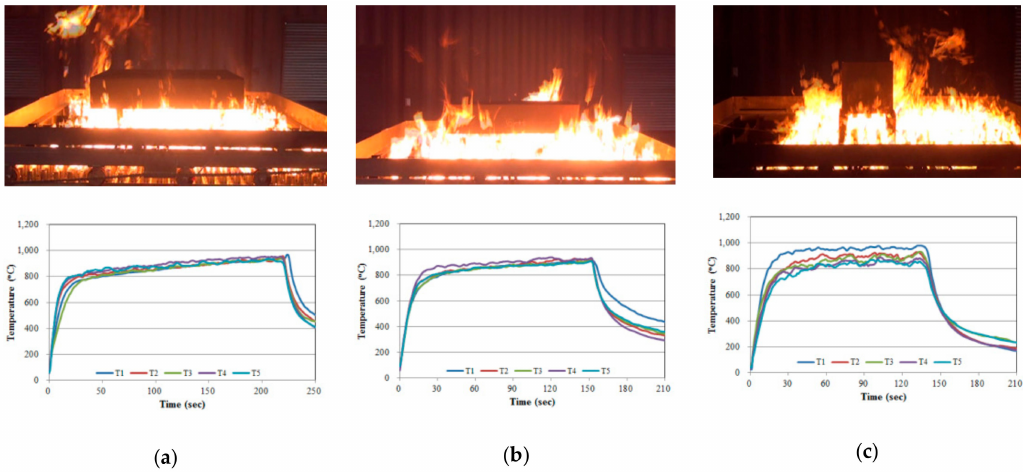
Figure 15. Experimental results of final test apparatus: ( a ) large mock-up; ( b ) medium-sized mock-up; ( c ) small